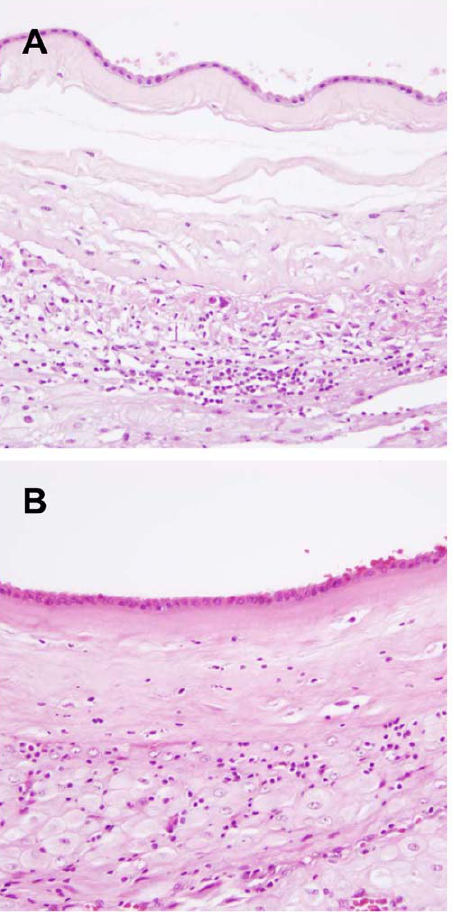
Figure 1. Histological features of chronic chorioamnionitis. (A) A case of spontaneous preterm birth showing destruction of the chorionic trophoblast layer by infiltrating lymphocytes. (B) In another case of spontaneous preterm birth, lymphocytic infiltration extended to the chorioamniotic connective tissue layer. Original magnification X200.